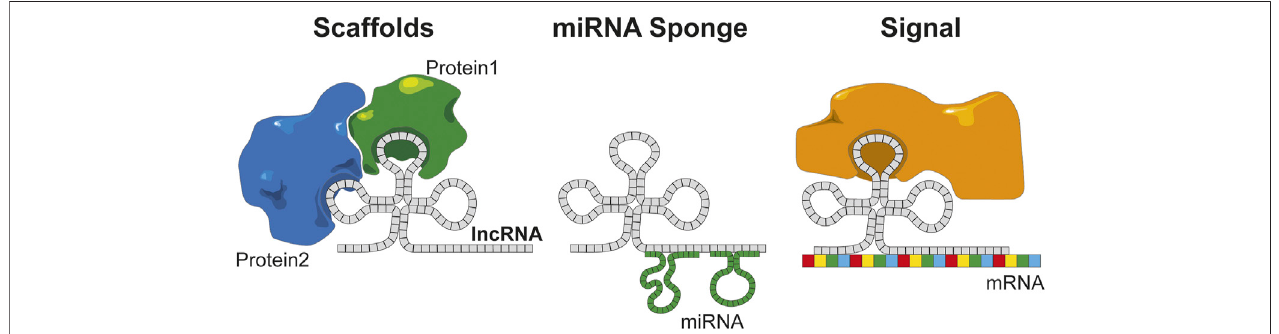
FIGURE2| lncRNAshaveseveralfunctionsbasedonthestructuralorganizationofthesequences.Scaffoldofproteinmaintainsproteininteraction,miRNAsponge regulates and inhibits the miRNA on the cell, and signal combines an RNA to a protein that can trigger the translation.